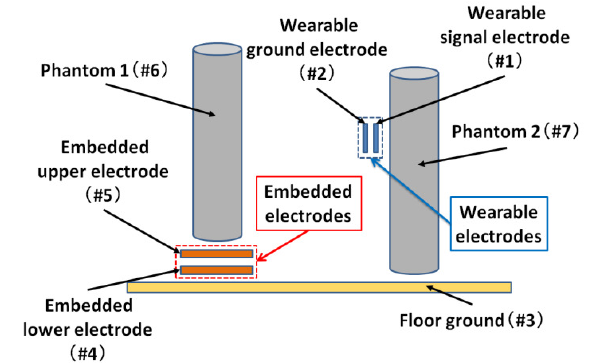
Figure 6. Signal interference model using seven conductors.